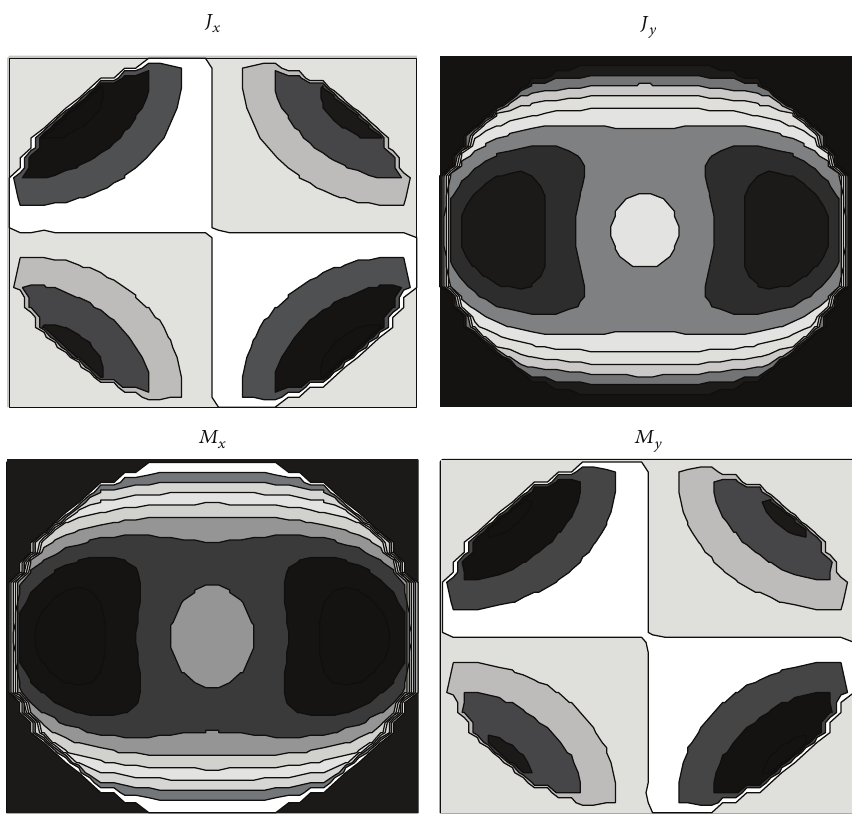
Figure 4: Current distribution over aperture of conical horn.